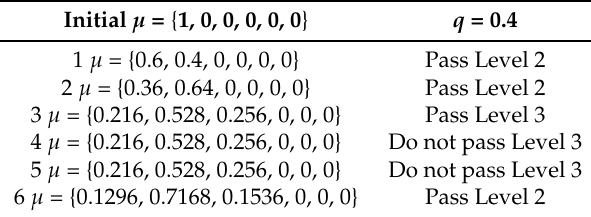
Table 2. An example of the membership grade changing rule when q = 0.4.